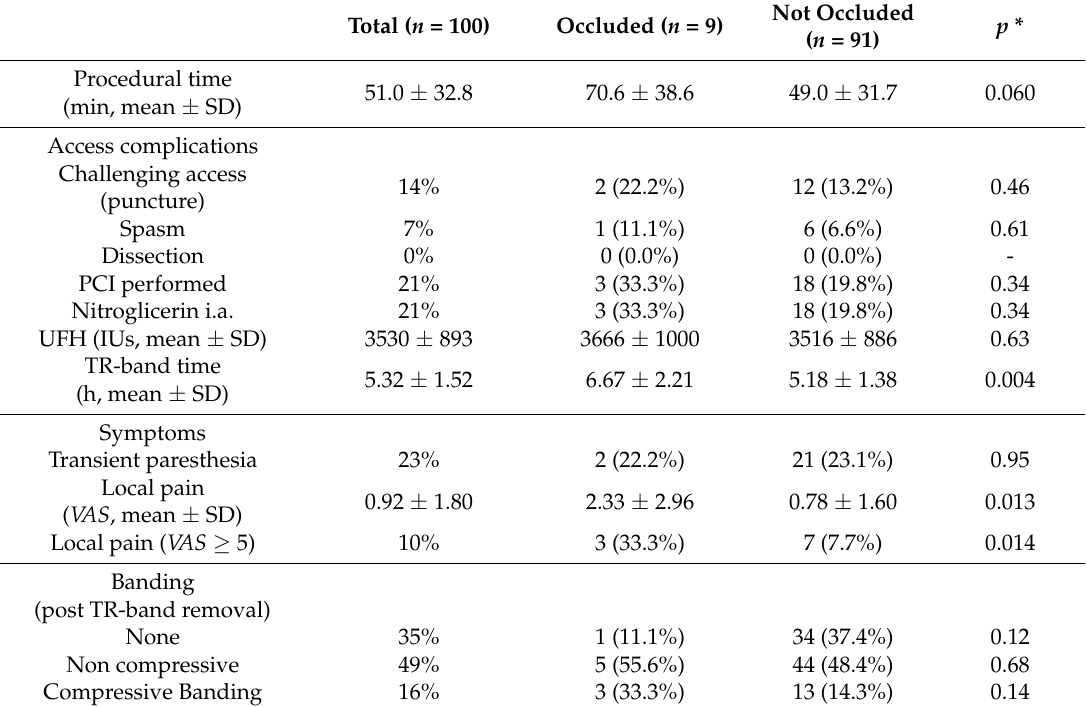
Table 2. Patients’ procedural characteristics according to radial artery patency